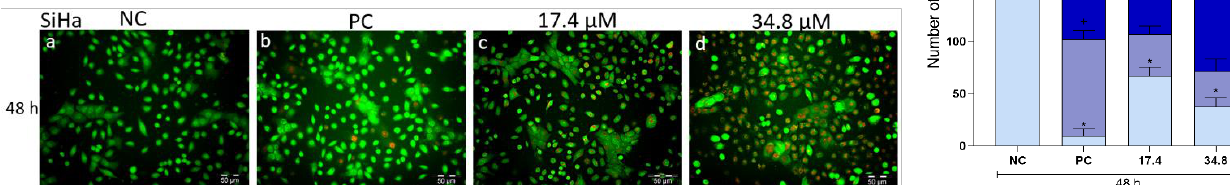
Figure 9. Effects of A3K2A3 on the possible type of death induced in cells. Annexin/IP tagging ( A ) HeLa and ( B ) SiHa. AO/PI marking ( C ) HeLa and ( D ) SiHa. Cells were treated with A3K2A3 (IC 50 or 2xIC 50 ) for 24 and 48 h for Annexin/PI labeling analysis and only 48 h for AO/PI marking. The PC was CPT (10 and 30µM). Quantifications were obtained by flow cytometry ( A e B ). Cells were visualized using an Olympus BX51 fluorescence microscope (Olympus, Tokyo, Japan), and images captured by a UC30 camera (Olympus, Tokyo, Japan) at (20× magnification; scale bar: 50 μm) followed by cell counts at each stage of apoptosis ( C e D ). Data represent the mean ± SD of three independent experiments that were performed in triplicate. ( A ) HeLa; ( B ) SiHa; * p < 0.05 compared to viable NC cells at 24 and 48 h, + p < 0.05 compared to NC cells in early apoptosis at 24 and 48 h, # p < 0.05 compared to NC cells in late apoptosis at 24 and 48 h (one-way ANOVA followed by Tukey ’ s post-test). ( C ) HeLa; ( D ) SiHa; * p < 0.05 compared to viable NC cells, + p < 0.05 compared to early apoptotic NC cells, # p < 0.05 compared to late apoptotic NC cells, $ p < 0.05 compared to necrotic NC cells (one-way ANOVA followed by Tukey ’ s post-test).